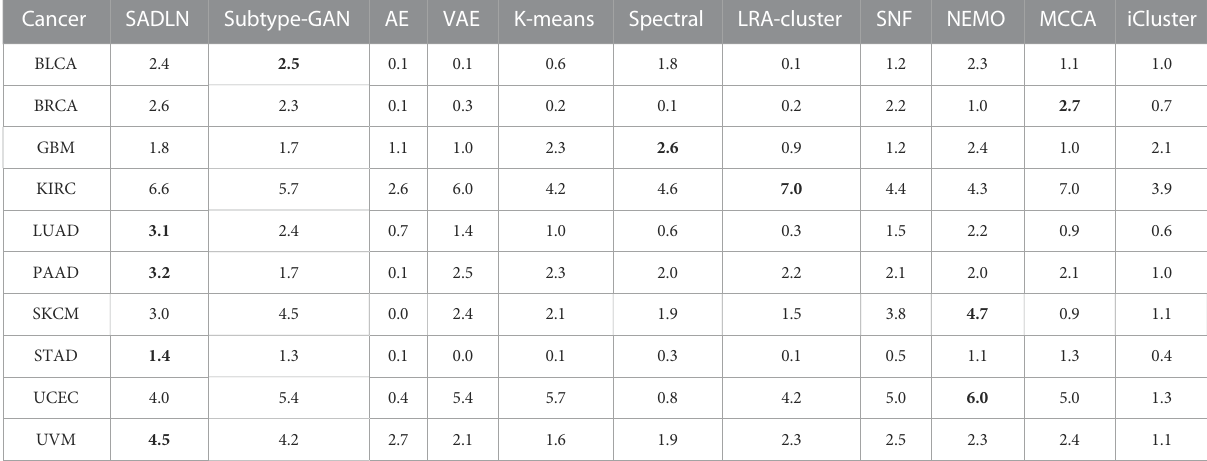
TABLE5The − log10 p valuesofsurvival analysisbased onCoxlog-rankmodeloften cancersdatasetsonTCGA(boldindicates thatthismethodperformsbest on the corresponding cancer dataset). Cancer